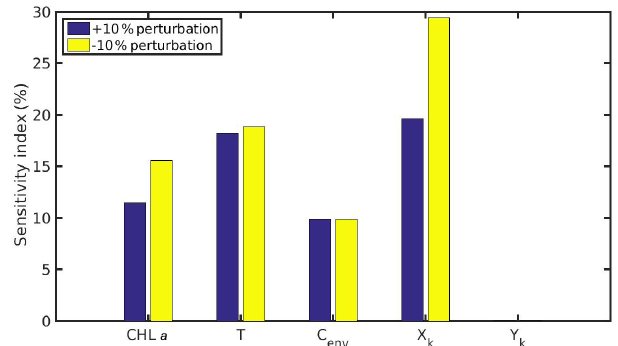
Figure 12. Sensitivity index of MPs accumulation for the cultured mussel of the northern Ionian Sea when variables (CHL a , temper- ature, C env ) and parameters ( X k ,Y k ) are perturbed ± 10%.